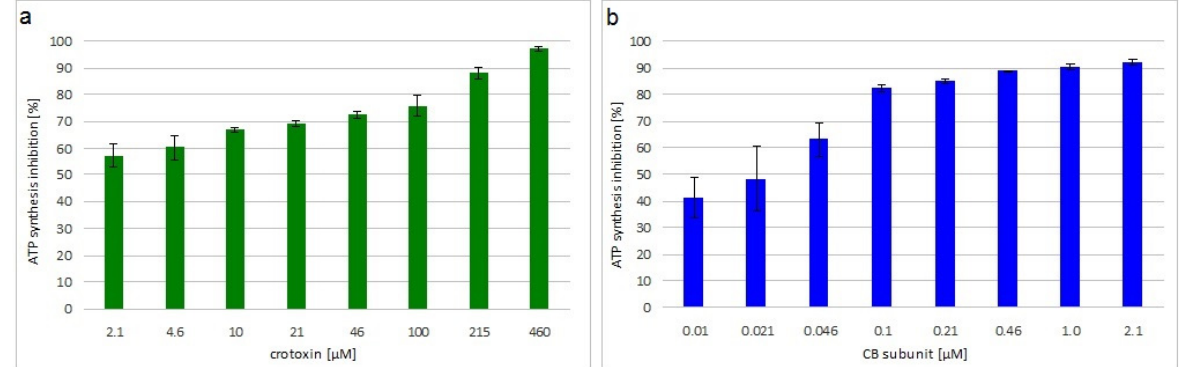
Figure 1. Viability of toxin incubated M. luteus . Average percentage inhibition of ATP synthesis by incubation with different concentrations of: ( a ) crotoxin or ( b ) CB subunit, relative to control, non-treated, cells. Error bars represent the standard deviation of three replicates.